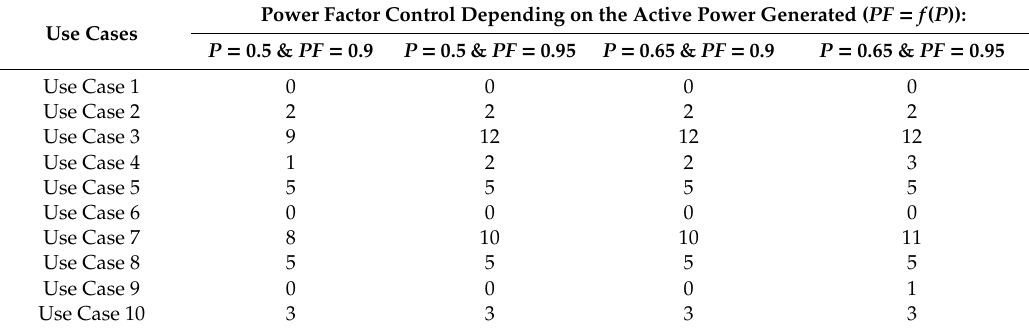
Table A8. Power factor control depending on the active power generated: Voltage